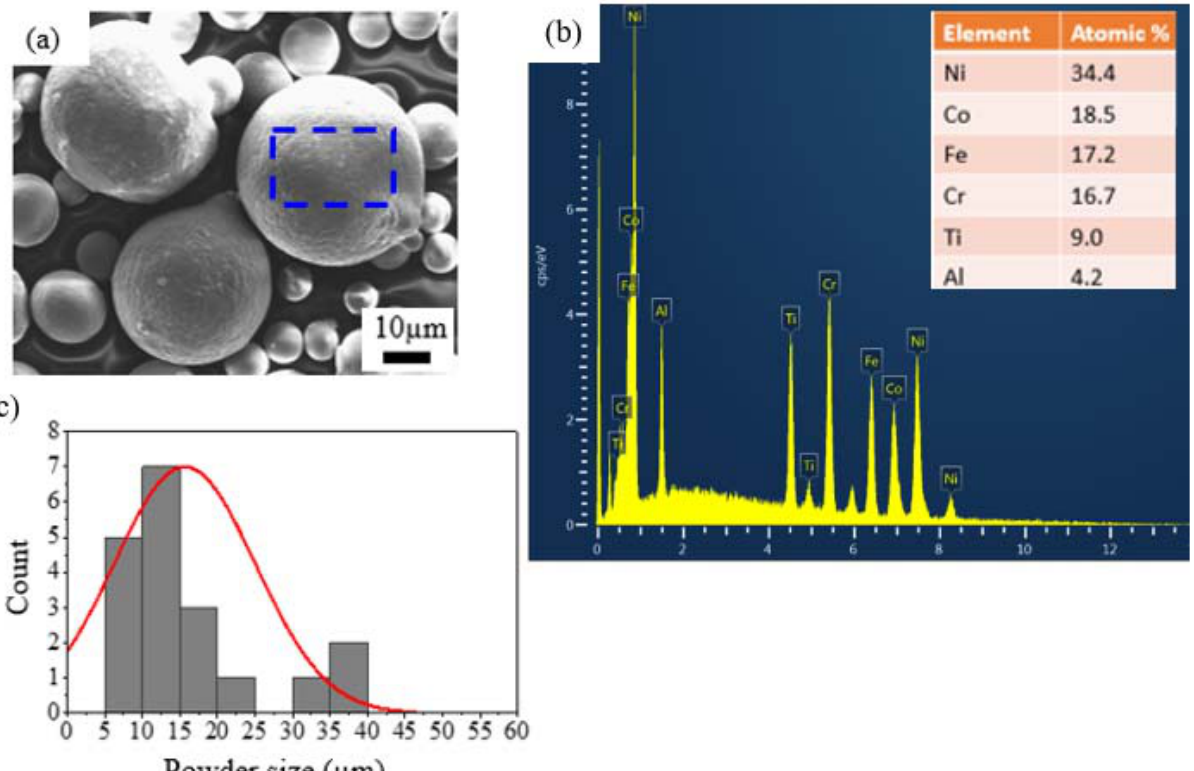
Figure 1. The 10–60 µ m gas-atomized Al 0.5 CoCrFeNi 2 Ti 0.5 powders ( a ) SEM image morphology and distribution, ( b ) EDS spectrum of the selected area shown in ( a ), ( c ) normal distribution graph for the particle size.